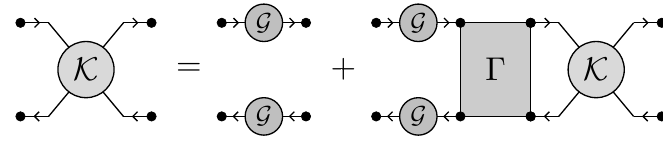
Figure 7 . Matrix Bethe-Salpeter equation